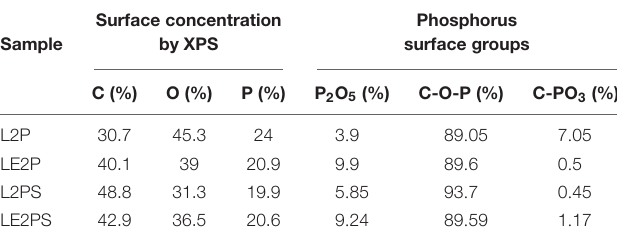
TABLE 1 | Mass surface concentration of the different H 3 PO 4 -lignin derived samples and the corresponding contribution of different phosphorus surface group obtained by XPS analyses.